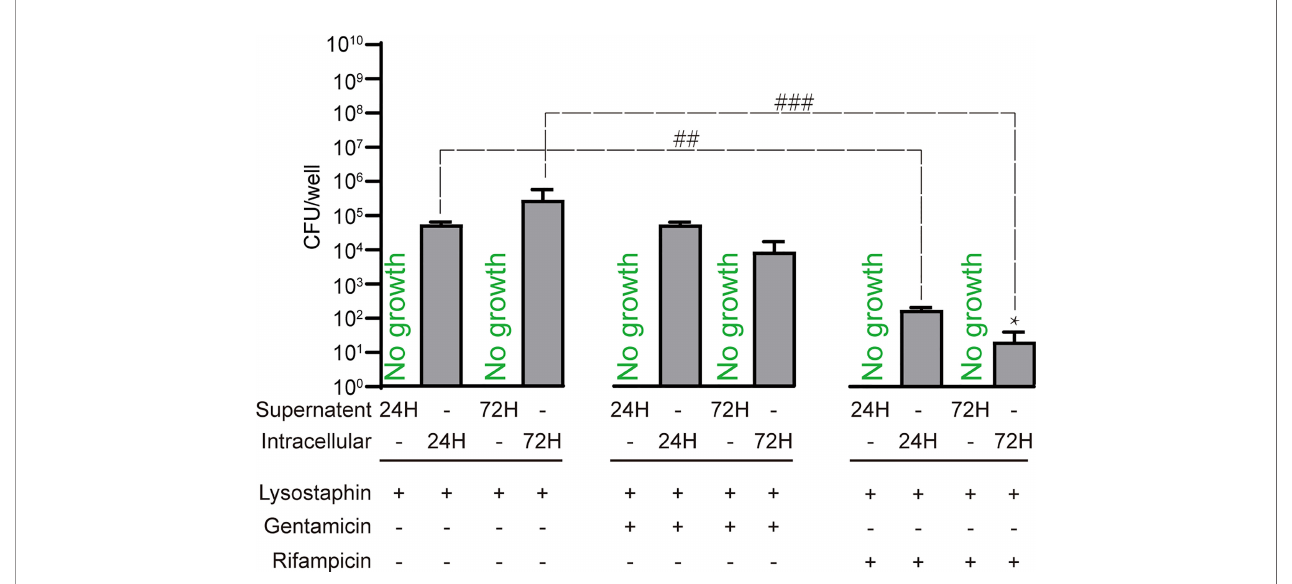
FIGURE 4 | Treatment of SaOS2-OY infected with an MOI of 1 WCH-SK2 with clinically utilised antibiotics. The antibiotic concentrations used were the minimum bactericidal concentration for planktonic growth of this strain, namely 450µg/ml and 0.75µg/ml for gentamicin and rifampicin, respectively. CFU were quanti fi ed after 24 and 72 hours of infection from either the lysate to determine bacterial burden or the supernatant to detect potential antibiotic resistance and escape from the intracellular niche. The negative control group was treated with lysostaphin for 2 hours post-infection to clear extracellular bacteria followed by culture in antibiotic free media. Data shown are means of quadruplicate wells ± SD. Signi fi cant difference between treatments is indicated by ## p < 0.01 and ### p < 0.001. Signi fi cant difference between time points is indicated by * p <